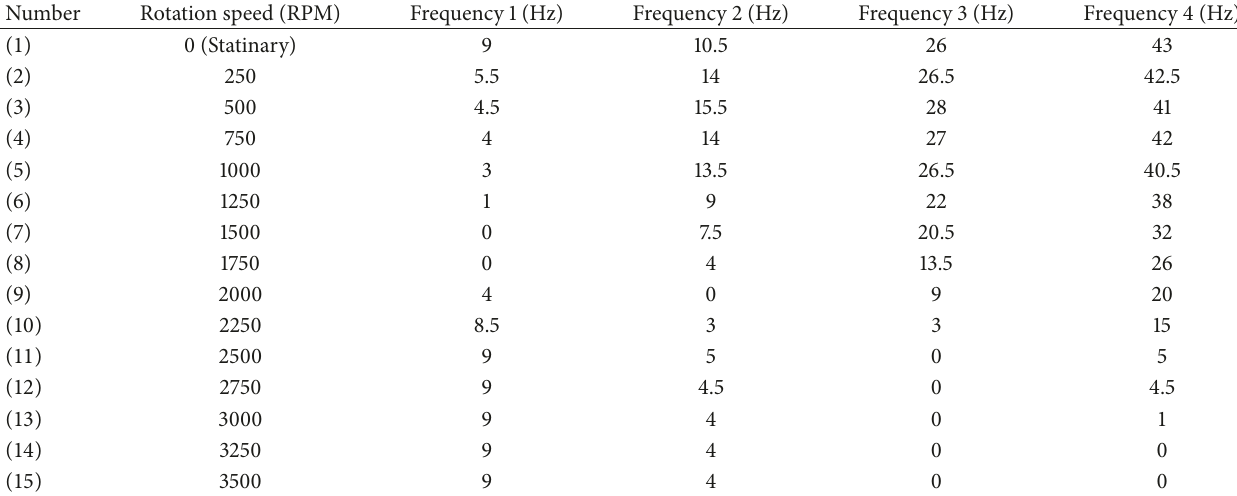
Table 5: Excited frequencies of the spline guided disk at different rotation speeds, FEM results.